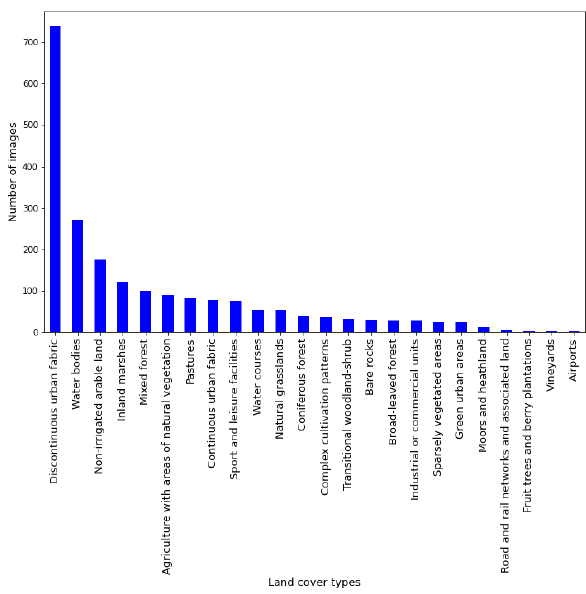
Figure 7: The distribution of Flickr images within various land cover classes from CORINE land cover map of